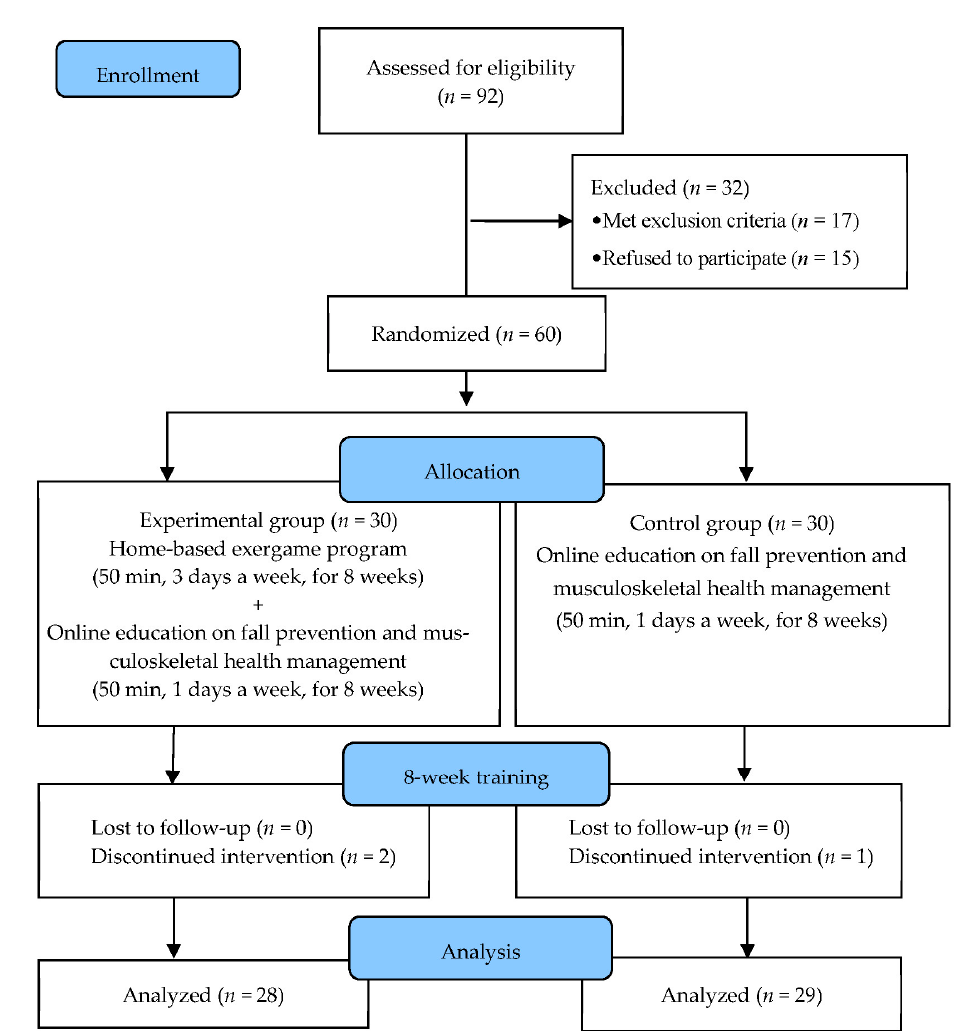
Figure 1. Flow diagram of the study.